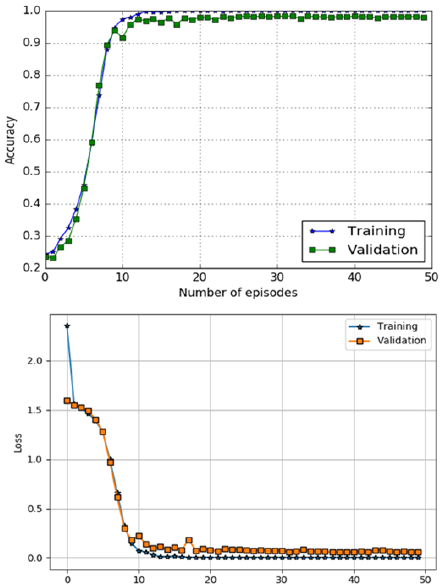
Figure 10. Accuracy and loss performance DL